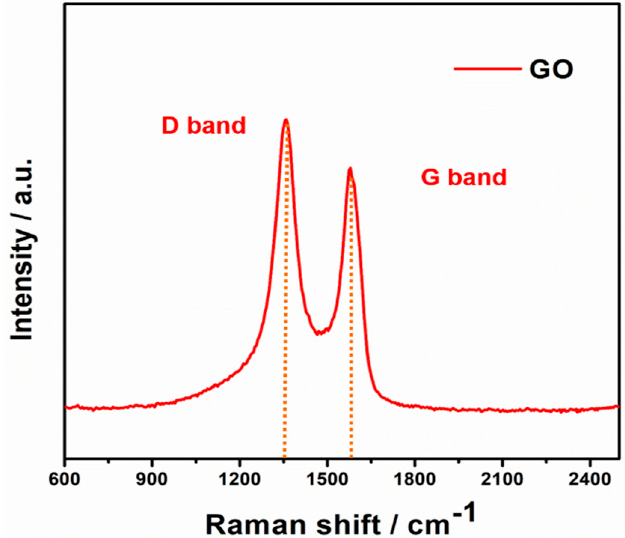
Figure 2. Raman spectra of GO with two prominent peaks at 1365 cm − 1 and 1597 cm − 1 , respectively.